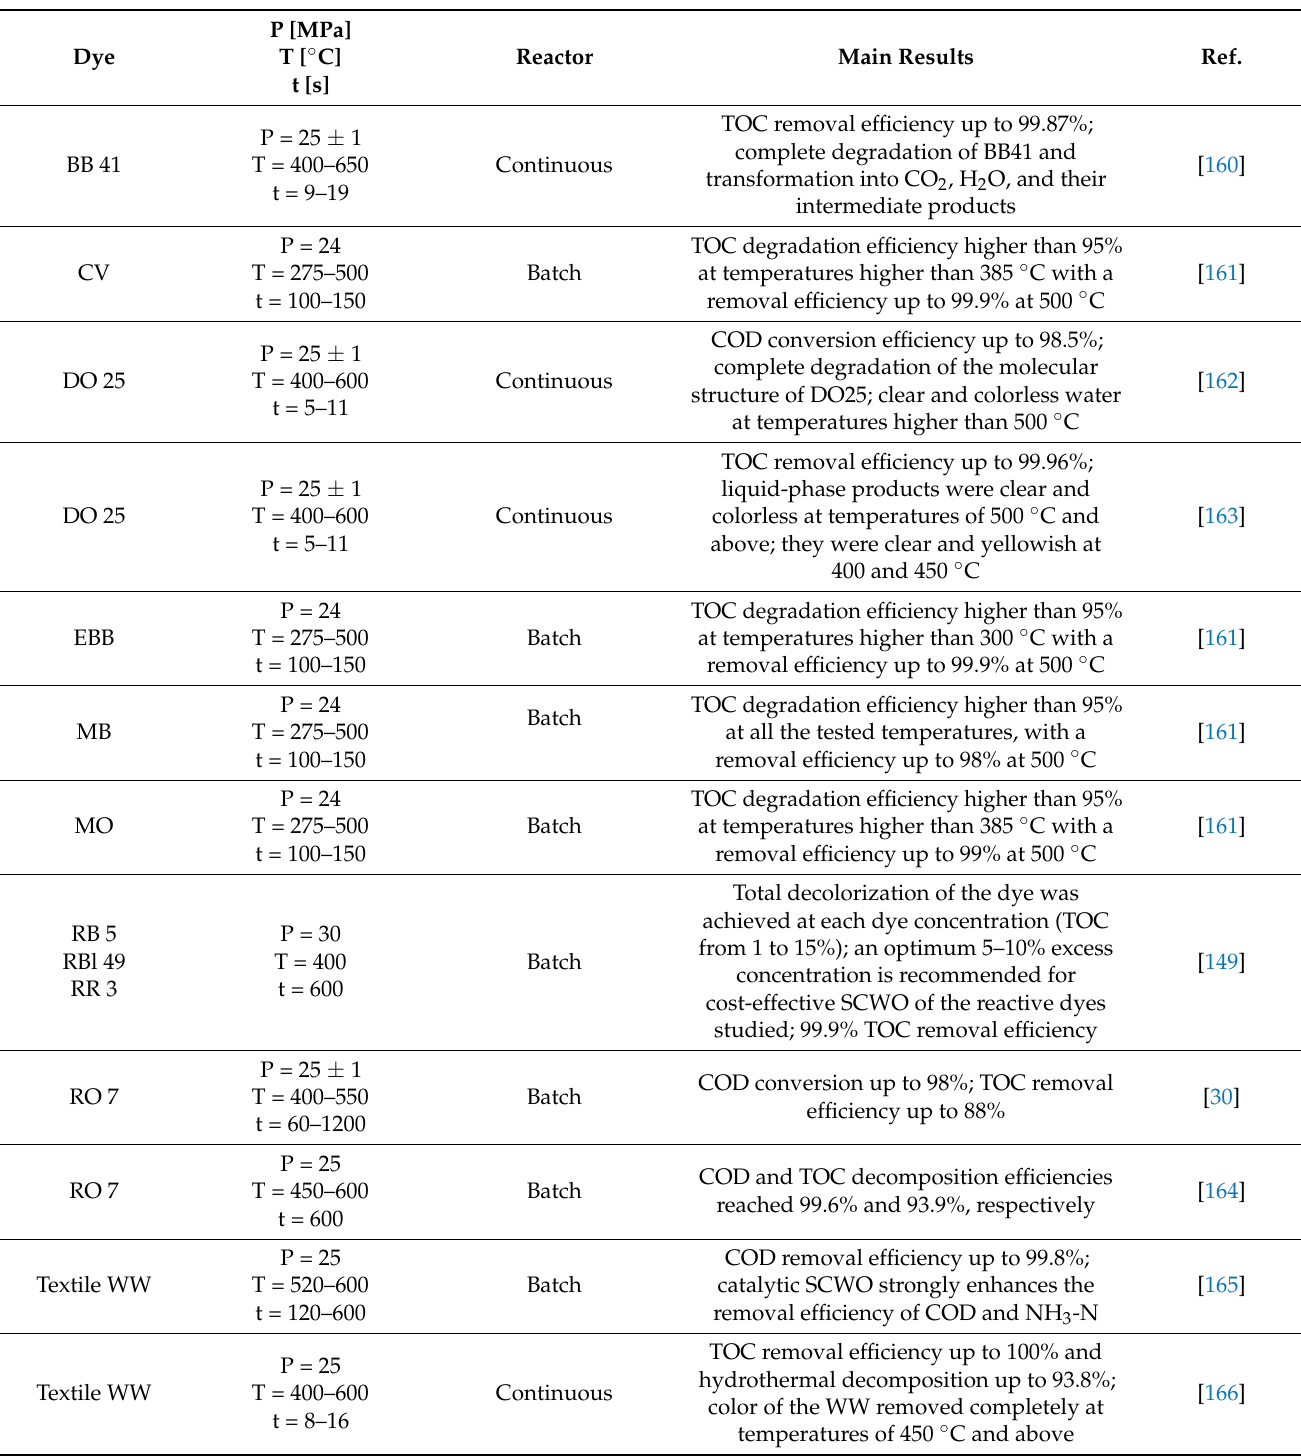
Table 2. SCWO main results with H 2 O 2 as the oxygen source. BB = Basic Blue; COD = chemi- cal oxygen demand; CV = Crystal Violet; DO = Disperse Orange; EBB = Eriochrome Blue Black; MB = Methylene Blue; MO = Methyl Orange; P = pressure; RB = Reactive Black; RBl = Reactive Blue; RO = Reactive Orange; RR = Reactive Red; t = residence time; T = temperature; TOC = total organic carbon; WW =